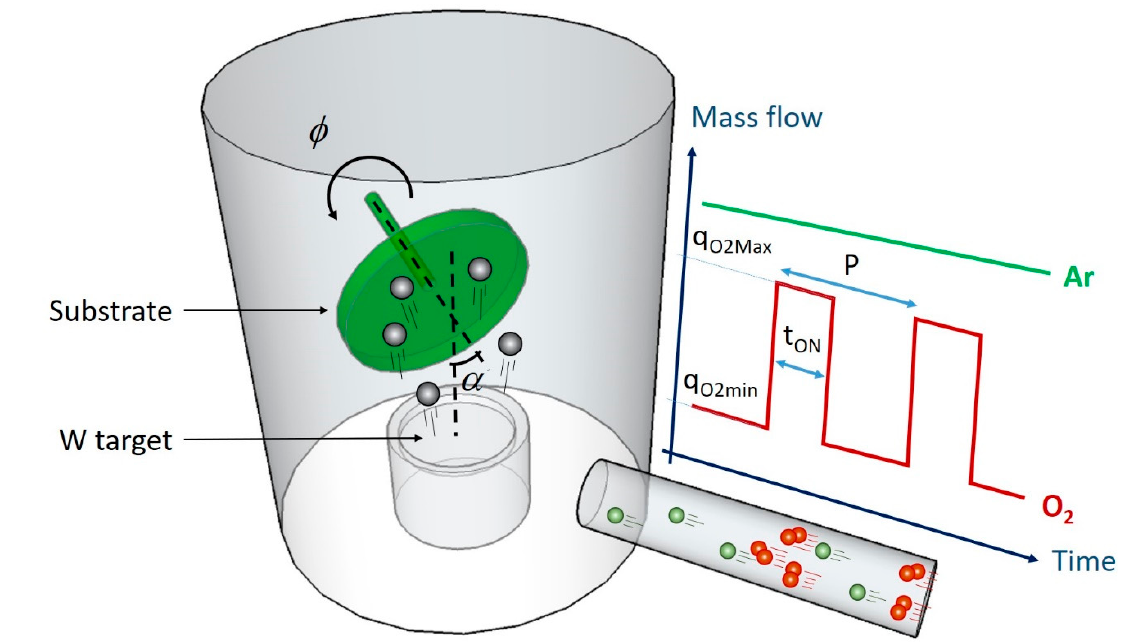
Figure 1. Schematic illustration of the vacuum sputtering system used to deposit tungsten oxide thin films coupling GLancing Angle Deposition (GLAD) and Reactive Gas Pulsing Process (RGPP) techniques. The substrate can be tilted (angle α between the normal axes of the substrate and target), fixed or rotated ( ϕ parameter) during the deposition stage. The tilt angle α can be adjusted from 0 to 90° and the substrate rotation ϕ can be 0 to a few revolutions per hour. Argon mass flow rate is kept constant, whereas oxygen mass flow rate is periodically controlled vs. time following a rectangular signal. Maximum and minimum oxygen flow rates ( q O2Max and q O2min , respectively), pulsing period P and oxygen injection time t ON are computer-controlled.